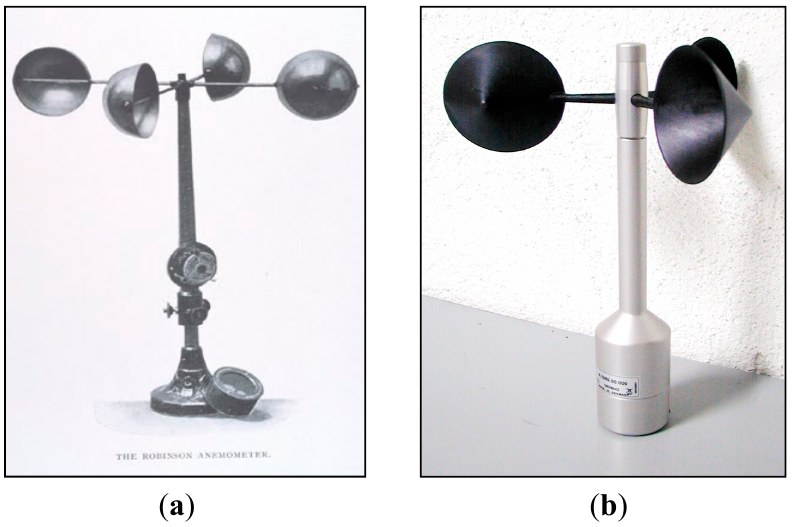
Figure 1. Old Robinson cup anemometer ( a ) and Thies Clima 4.3350 cup anemometer ( b ).